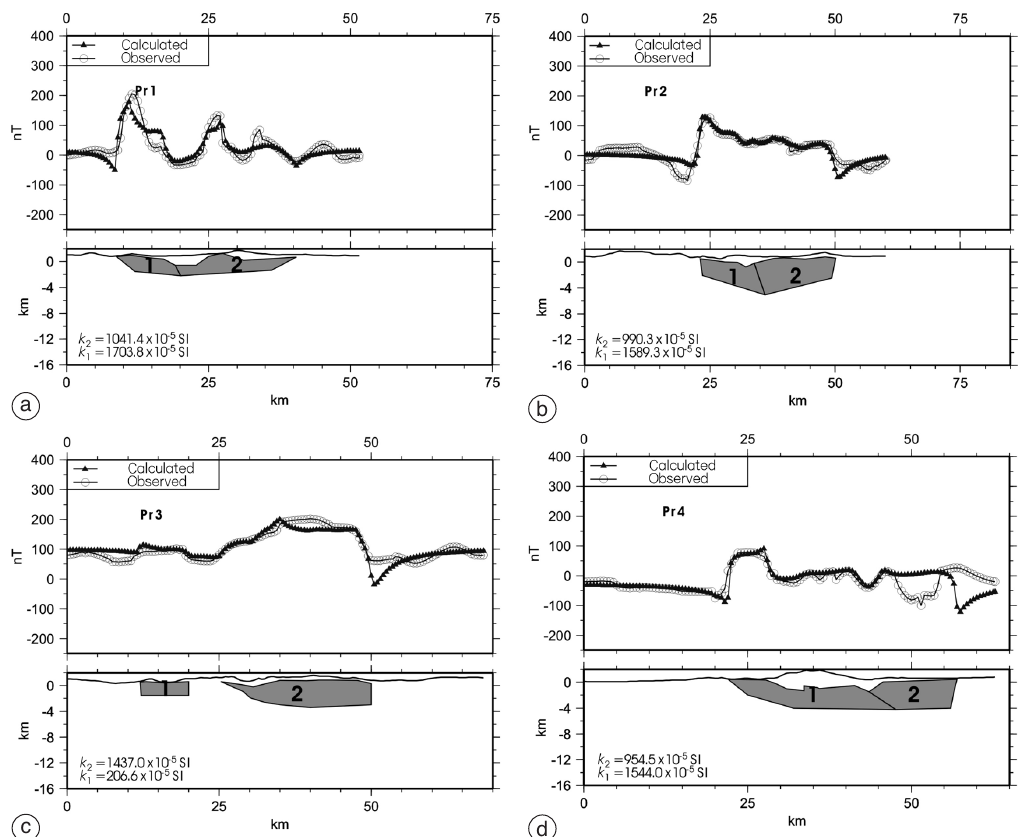
Fig. 11a-d. 2.5D modeling of the magnetic sources along the profiles Pr1 (a), Pr2 (b), Pr3 (c) and Pr4 (d) (see fig. 2 for the location of